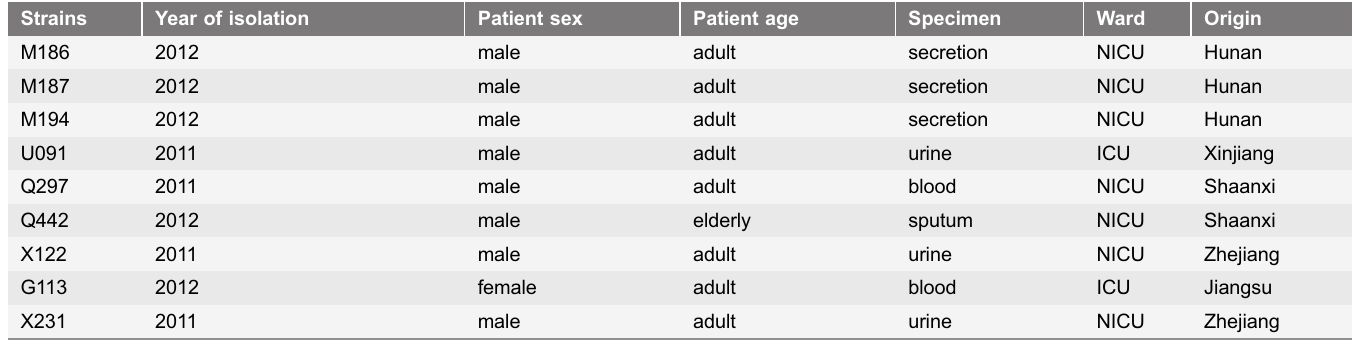
Table 1. Epidemiological characteristics of nine bla NDM-1 -positive bacteria.